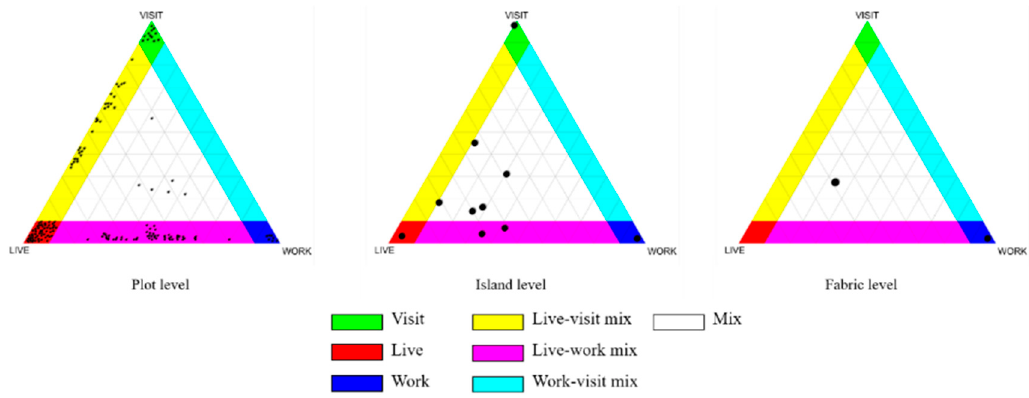
Figure 14. Live / visit / work triangle at three Figure 14. Live/visit/work triangle at three levels.